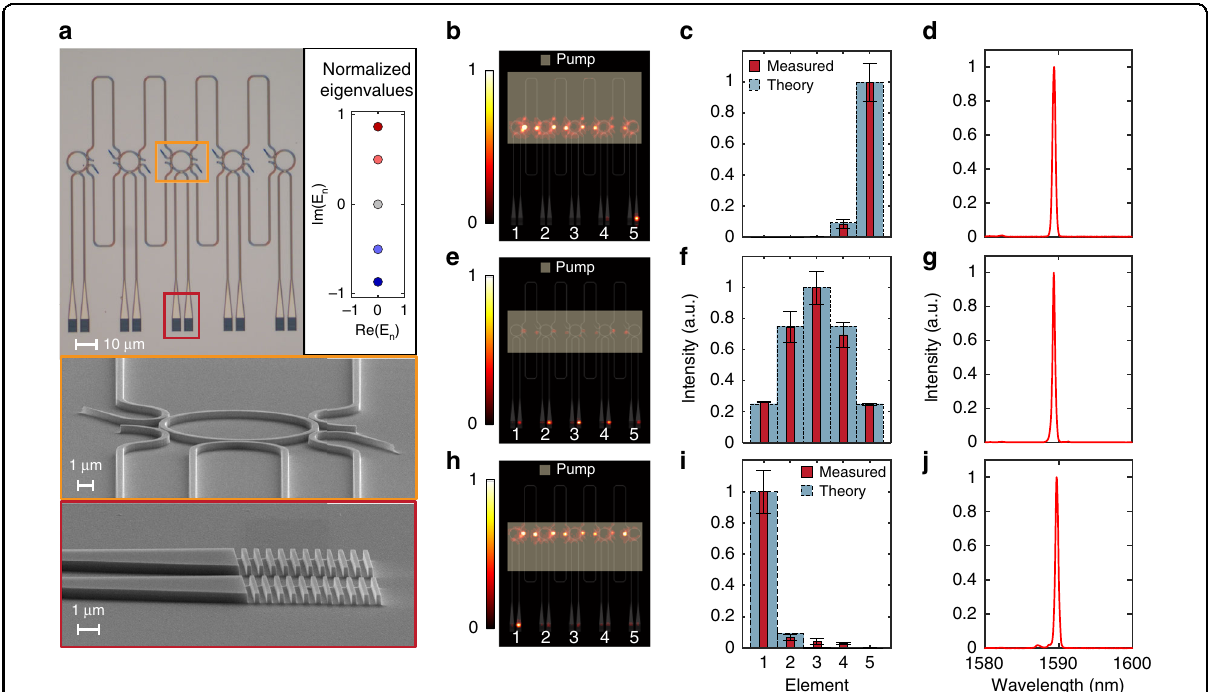
Fig. 3 A 5-element Hatano – Nelson phase locked microring laser array. a Microscope and scanning electron microscope (SEM) images of the 5-element systems. Inset on the top right, Normalized eigenvalues when β L ffi m π . The mode with highest imaginary eigenvalues (dark red circle) will be the only lasing mode in the system. b – j Experimental conditions and results for the 5-element Hatano – Nelson lattice. Under three different pumping pro fi les, upper ( b ), middle ( e ), and lower ( h ), the 5-element system can be controlled to demonstrate the non-Hermitian skin effect towards two different directions ( b , h ) or return to its trivial form where the right and left couplings are equal ( e ). The intensity at various sites are reported (the error bars show the variation over 15 measurements) ( c , f , i ). The link length is designed to promote single-mode lasing behavior and the measured spectra con fi rm that this condition is satis fi ed ( d , g , j ). The number of the data points in the spectra is